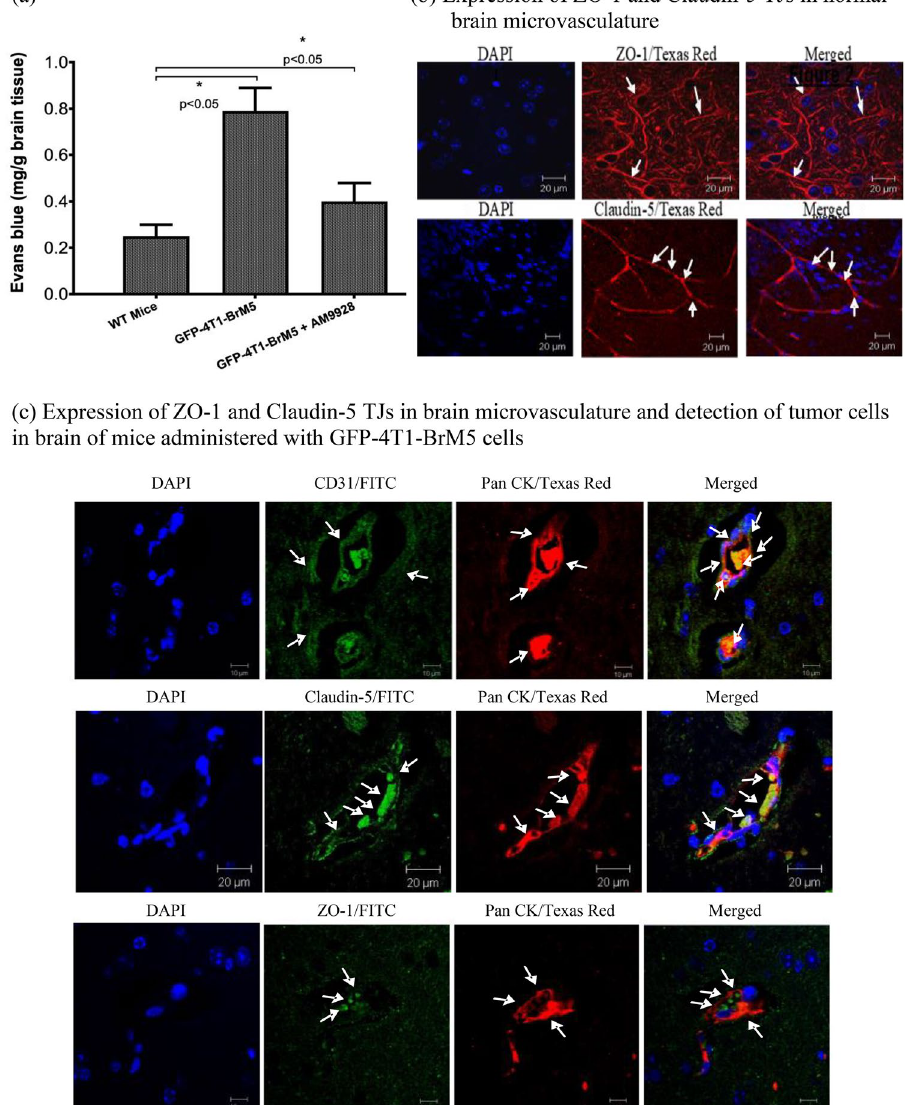
Figure 5. In vivo effect of AM9928 on transmigration of GFP-4T1-BrM5 cells across the BBB and on BMEC-Tight Junctions expression. ( a ) In vivo analysis of the BBB permeability: following injection of Evans blue, a statistically significant increase of the dye was found in the hippocampal region in mice administered with GFP-4T1-BrM5 cells and treated with vehicle control, but not in mice treated with AM9928. The level of dye in the control WT mice is shown also for comparison between the groups. This is a representative experiment of three separate experiments. The error bars indicate standard deviations. * p < 0.05 as compared to WT mice control. ( b ) Immunodetection of tight junctions in normal brain CD31 positive microvasculature (BMECs). The normal brain microvasculature was immunoassayed with CD31 antibody (1:500 dilution) as a marker for BMECs, using FITC- conjugated secondary antibody. Brain sections were immunoassayed for ZO-1(1:500 dilution) and Claudin-5 (1:500 dilution) using fluorescence Texas Red secondary antibody to detect ZO-1 and Claudin-5 expression in normal mouse brain sections. Arrows show the intact ZO-1(red) and Claudin-5 (red) structures, as indicated. Brain nuclei were counterstained with DAPI (blue). These are representative images of over 50 fields examined in three independent experiments. Scale bar = 20 μm. ( c ) In vivo effects of GFP-4T1-BrM5 tumor cells on the BBB integrity and on tight junctions’ structures: upper panel: the tumor cells were detected by pan-cytokeratin (Pan-CK) antibody (1:500 dilution) as primary antibody and fluorescence Texas red was used as a secondary antibody to detect the tumor cells in brain sections of mice administered with GFP-4T1-BrM5 cells. The brain microvasculature was immunoassayed with CD31 antibody (1:500 dilution) to detect BMECs (red). The arrows indicate the tumor cells or the CD31 BMECs as indicated. These are representative images of over 50 fields examined in three independent experiments. Magnification—× 40; scale bar-10 μm. Middle and Lower Panels: Immunodetection of tight junctions in brain tumors: Expression of Claudin-5 (middle panel) (green) and ZO-1 (lower panel) (green) in tumor brain sections were performed by immunostaining using FITC-conjugated secondary antibody as indicated. Detection of GFP-4T1-BrM5 cells in vivo was performed by immunostaining with Pan-CK antibody (red). Co-immunostaining of the tumor cells with Claudin-5 or with ZO-1 are shown in the merged figures. Brain nuclei were counterstained with DAPI (blue). These are representative images of over 50 fields examined from three independent experiments. The magnification—× 40; scale bar-10